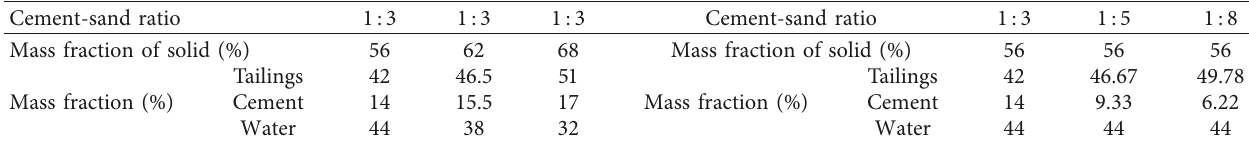
T ABLE 2: Proportion calculation of experimental